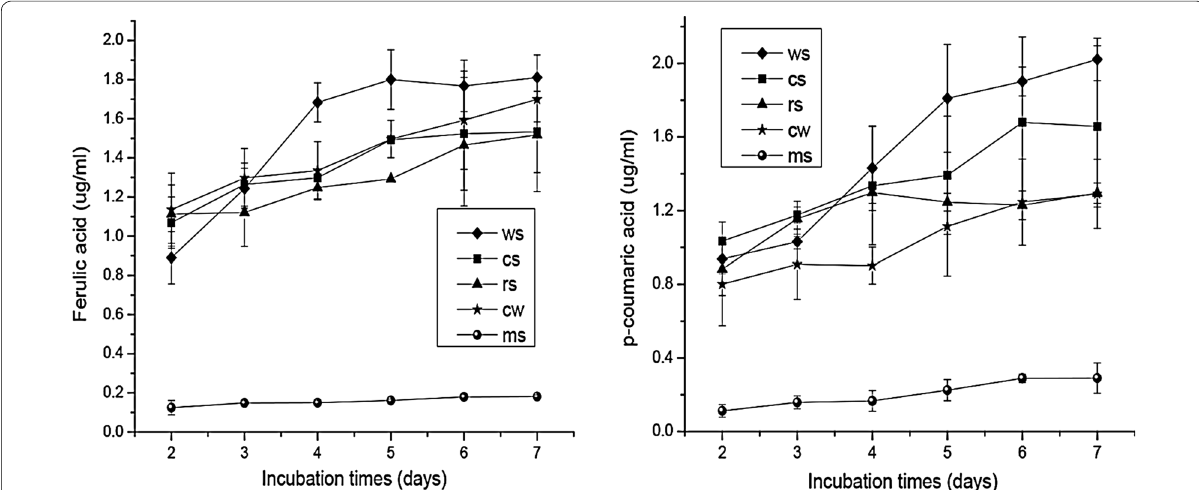
Fig. 3 Releases of ferulic acid and p ‑coumaric acid by the ( Piromyces stalk, rice straw, Chinese wildrye and medicago sativa during the 7 days’ incubation (wheat straw diamond , corn stalk square , rice straw triangle , Chinese wildrye star , medicago sativa circle )